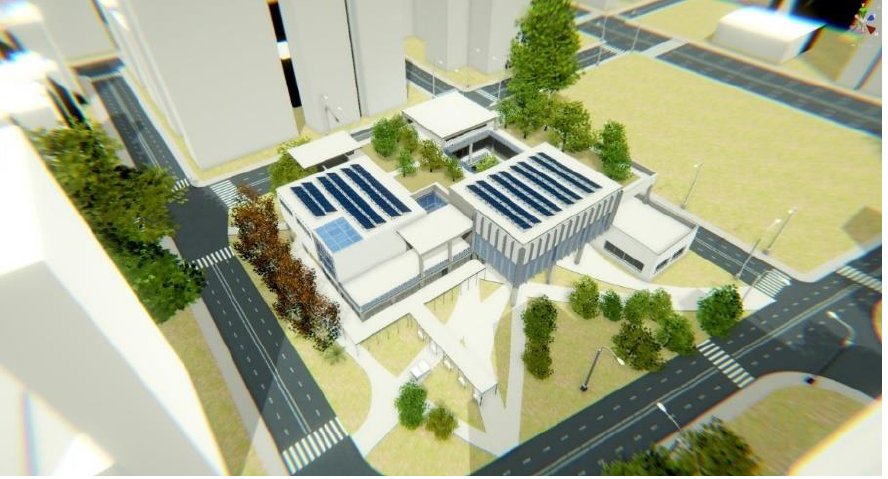
Figure 4. BIM-based VR model.